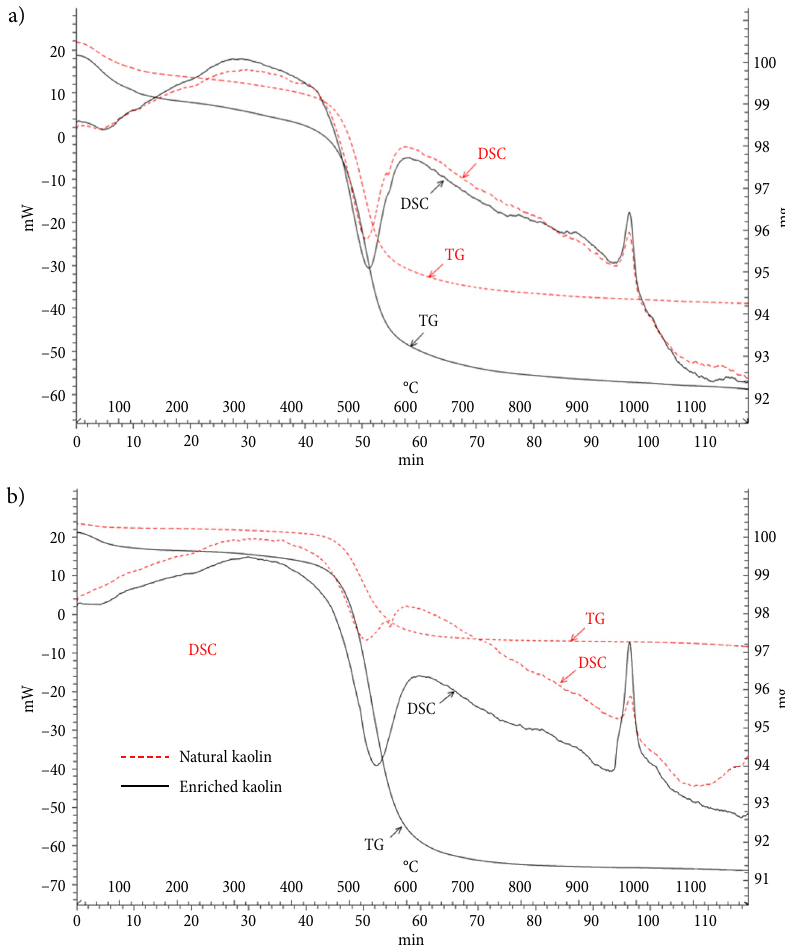
Fig. 1. Derivation of kaolin deposits “Sitnitsa” (a) and “Dedovka”